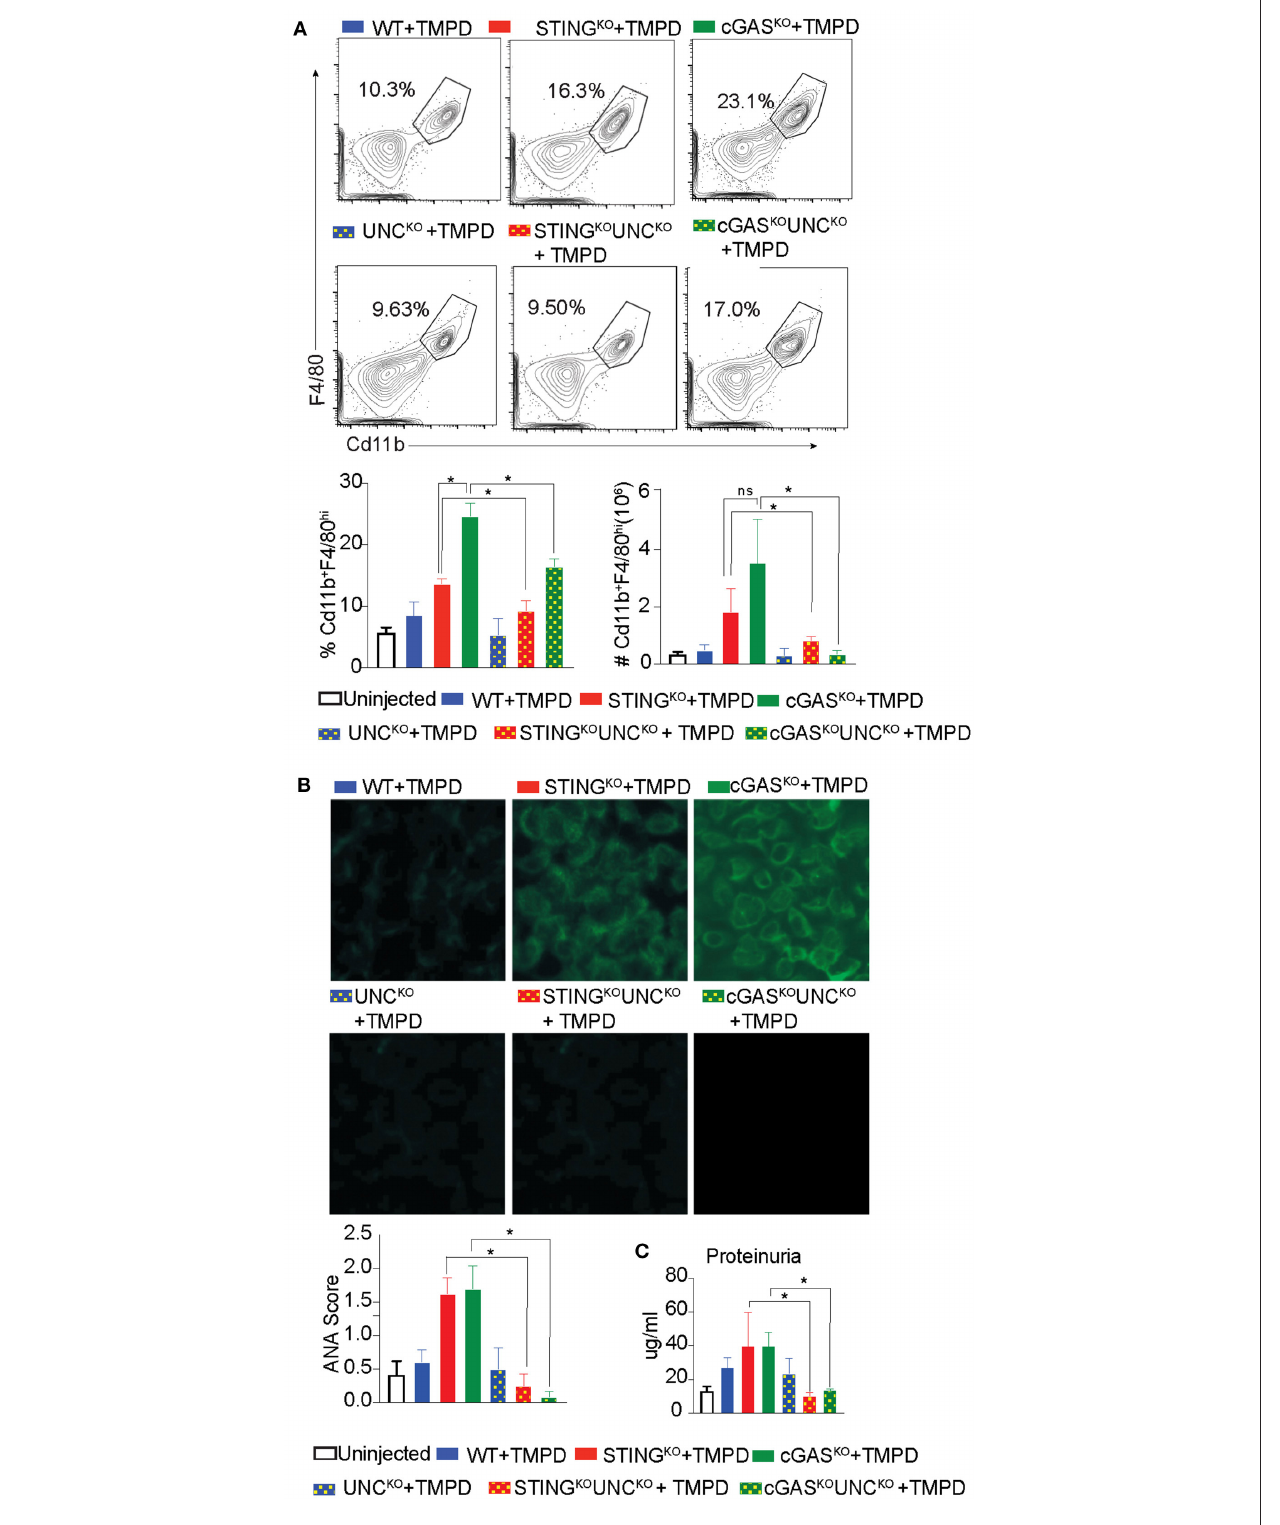
FIGURE 3 | Exacerbation of TMPD-induced SLE in cGAS or STING deficient mice is dependent on endosomal TLRs. 12–16 week old female WT (blue), STING KO (red), cGAS KO (green), UNC KO (blue with dots), UNC KO STING KO (red with dots), and UNC KO cGAS KO (green with dots) mice were injected with 500 ul of TMPD